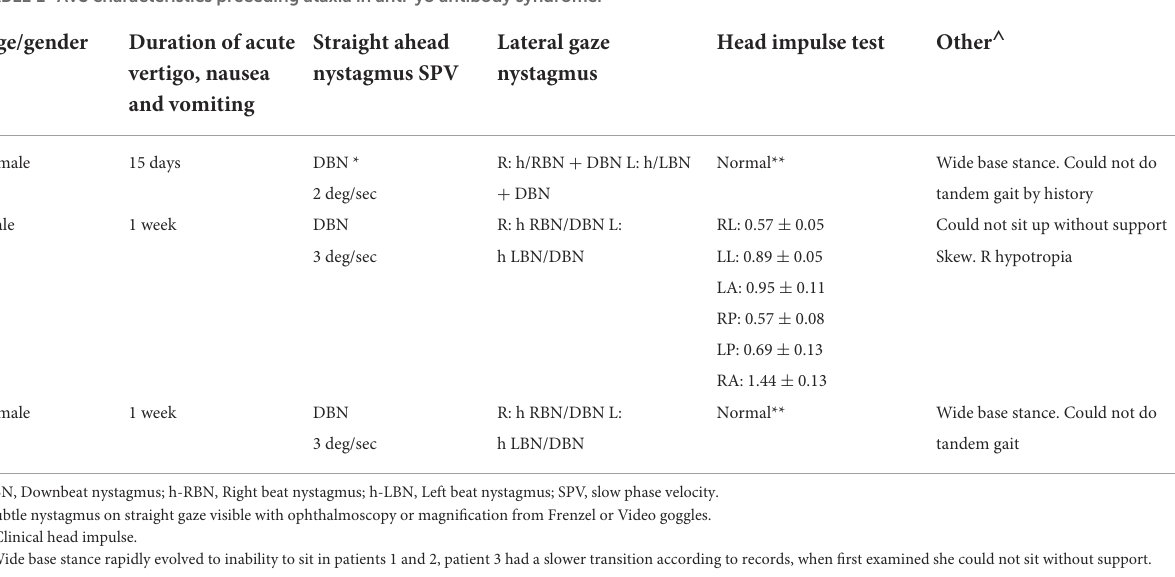
TABLE 1 AVS characteristics preceding ataxia in anti-yo antibody syndrome.